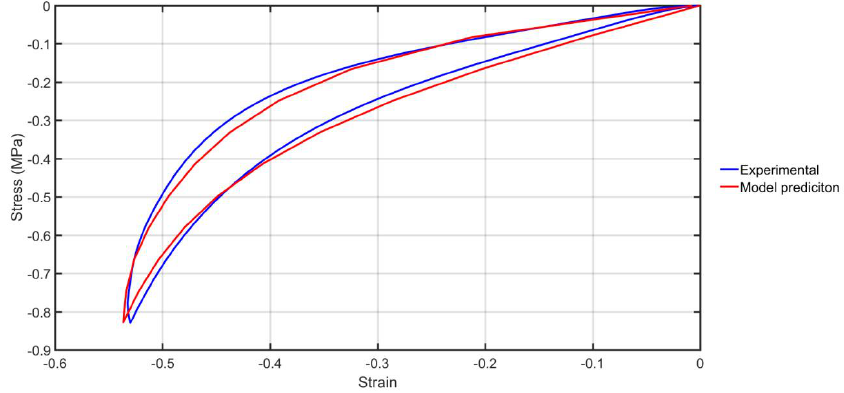
Figure 4. Nominal stress strain curves taken from the experimental data and the FE model prediction using the microfoam material